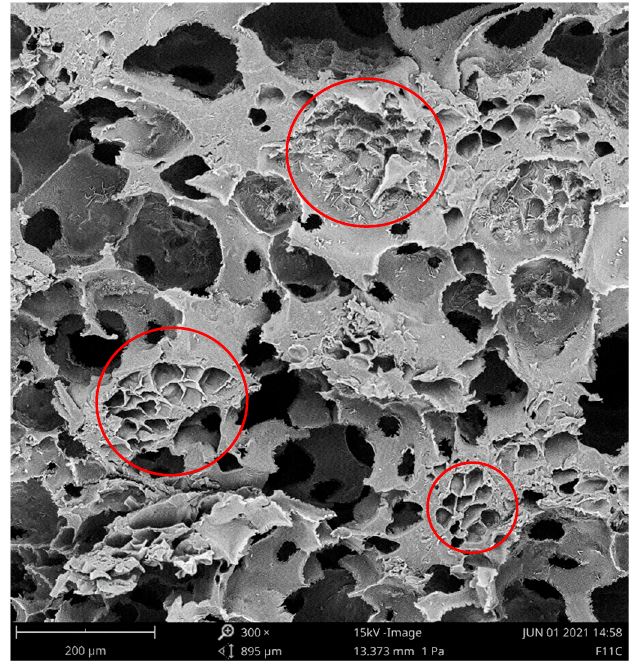
Figure 3. SEM images of the cross-section of F11 composite coating. The coating was fractured under liquid nitrogen. Red circles point out some of the cork granules present. Magnification: 300×.